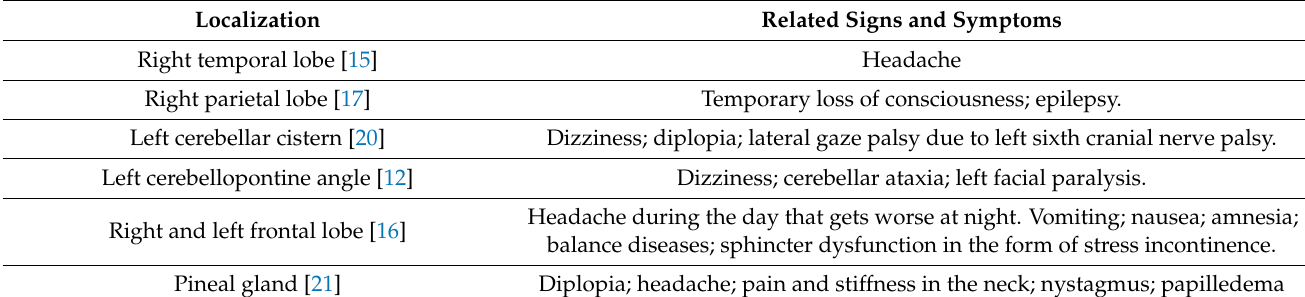
Table 1. Localization of the intracranial epidermoid cyst and related signs and symptoms. Localization Related Signs and Symptoms Right temporal lobe [15] Headache Right parietal lobe